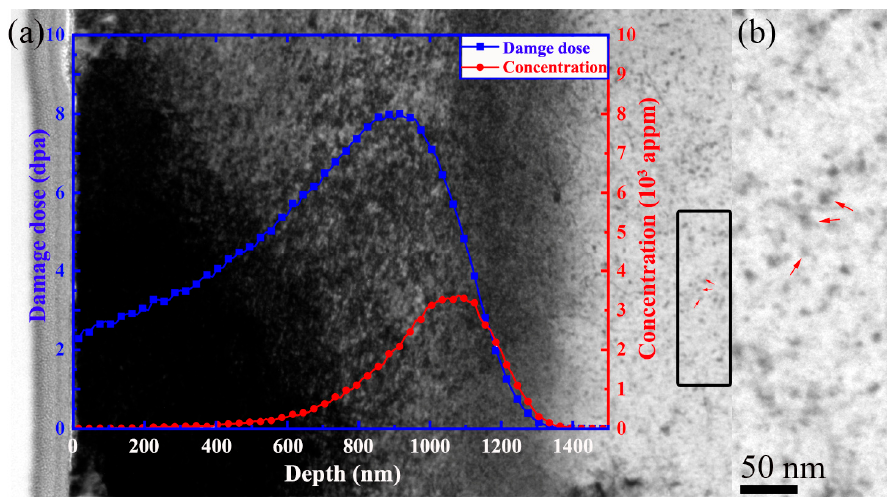
Figure 1. ( a ) SRIM calculation of damage and concentration under 2.5 MeV V 2+ irradiation with a fluence of 9.17 × 10 15 ions cm − 2 in V-4Cr-4Ti alloy, ( b ) the magnification image of the black dotted line on the right side of Figure 1a.